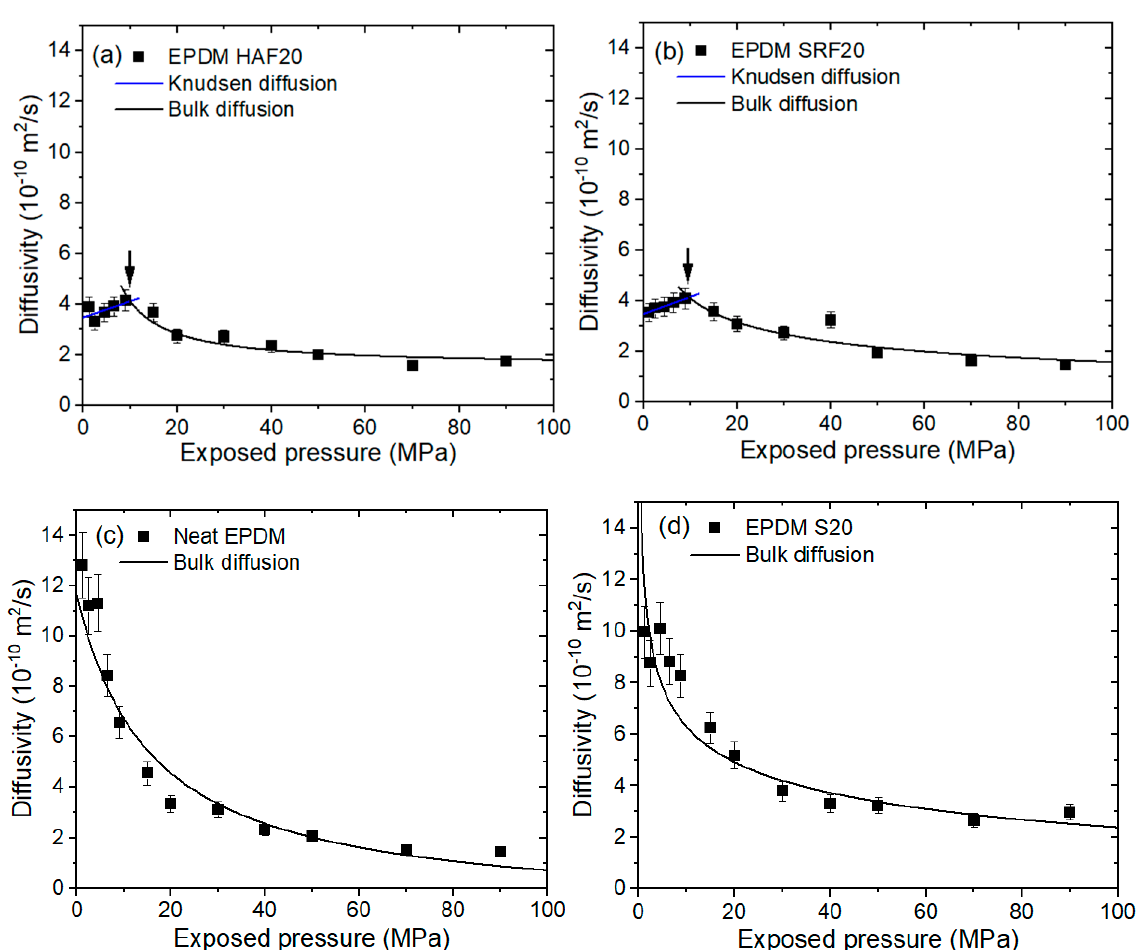
Figure 7. H 2 diffusivity versus exposed pressure in ( a ) EPDM HAF20, ( b ) EPDM SRF20, ( c ) neat EPDM, and ( d ) EPDM S20. The blue lines indicate Knudsen diffusion fitted by Equation (5). The black lines indicate bulk diffusion fitted by Equation (6). The arrows in ( a , b ) indicate the intersecting regions of Knudsen and bulk diffusion.